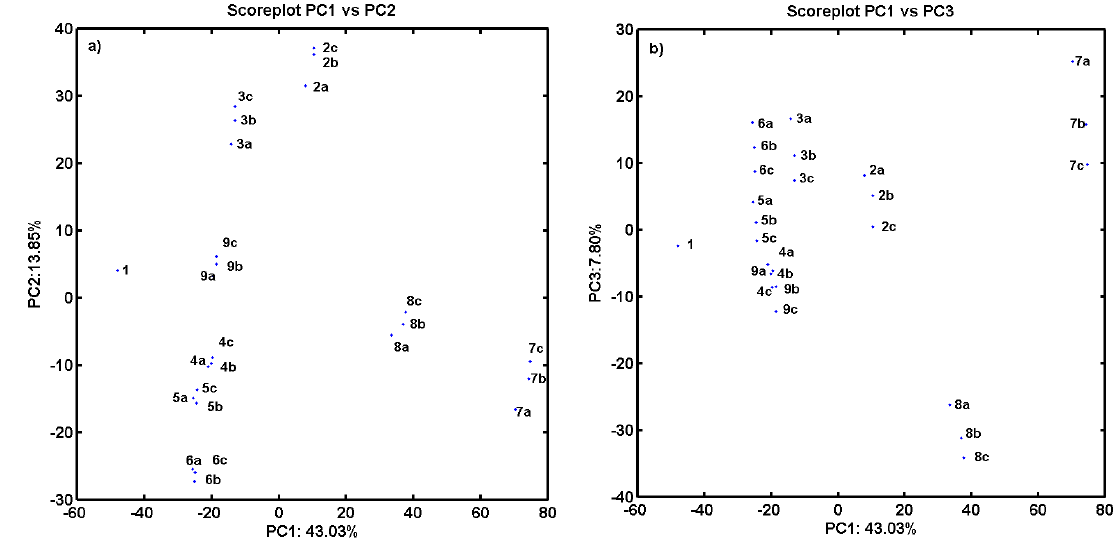
Figure 2. Projection of carbamates 1 – 9c on plane defined by: first vs. second ( a ); and first vs. third ( b ) principal components for Dragon descriptors.